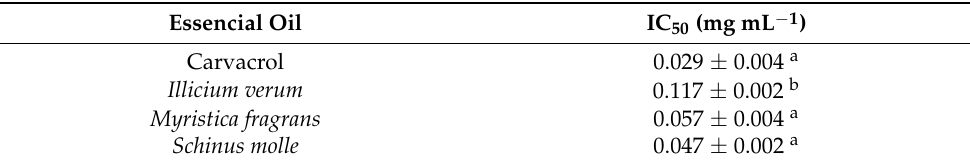
Table 3. Estimated IC 50 values for acetylcholinesterase